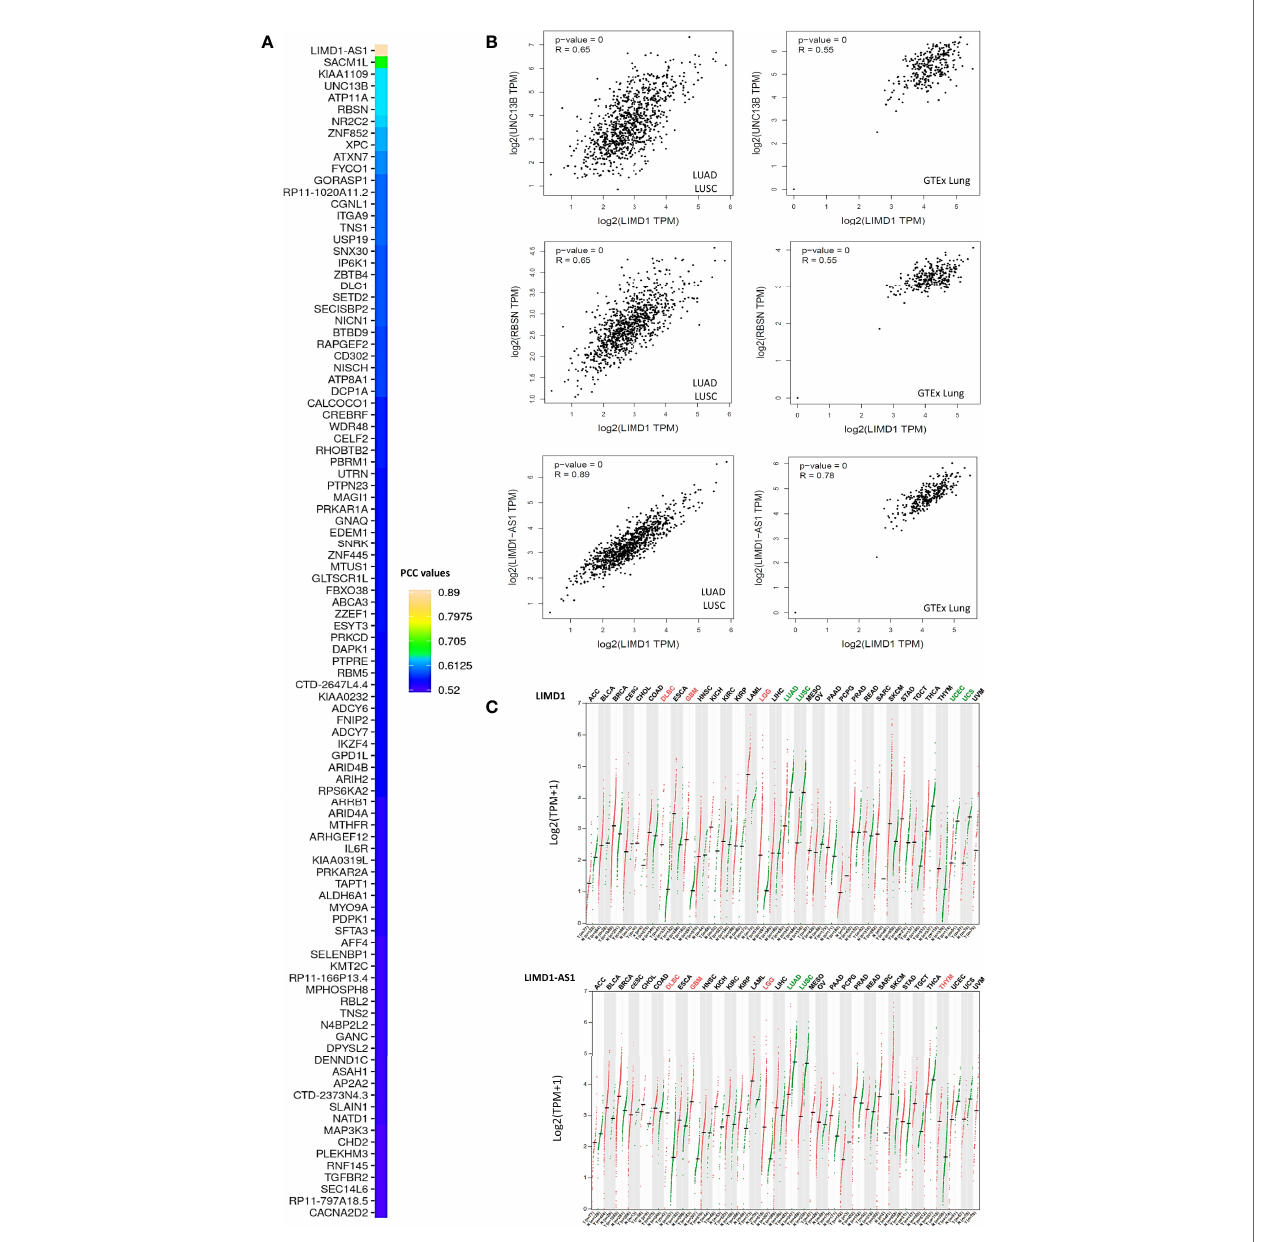
FIGURE 5 | LIMD1-associated molecular signature in NSCLC. (A) Pro fi ling genes coexpressed with LIMD1 in NSCLC in GEPIA2. Pearson correlation coef fi cient values (PCC) >0.5 are shown. (B) Validation of individual genes in association with LIMD1 transcription in GEPIA2. (C) Similar expression patterns of LIMD1 and LIMD1-AS1 across various cancer versus normal tissues, as analyzed in GEPIA2. Cancer types are labeled on the top of the graphs, with red fonts showing signi fi cant upregulation and green fonts showing signi fi cant downregulation. T, Tumor tissues (Red dots); N, Normal tissues (Green